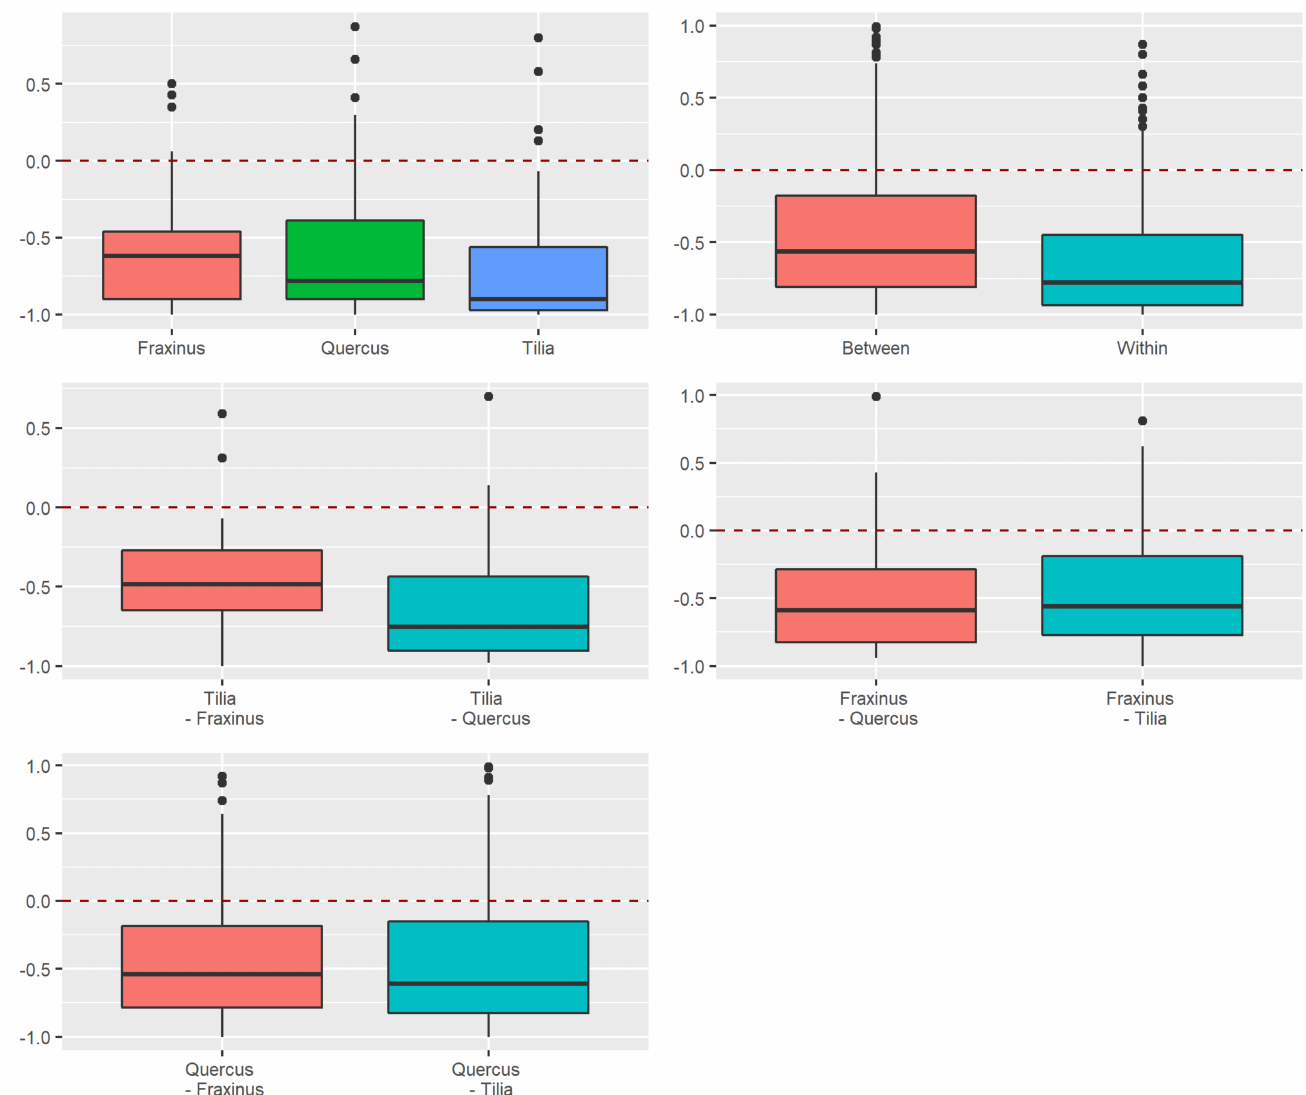
Figure A4. Deviation of the beta diversity from the diversity expected by the null hypothesis per tree species for the common beetle species. Comparisons within a tree species are comparisons of two traps of the same tree species. Comparisons between tree species are comparisons of two traps from two different tree